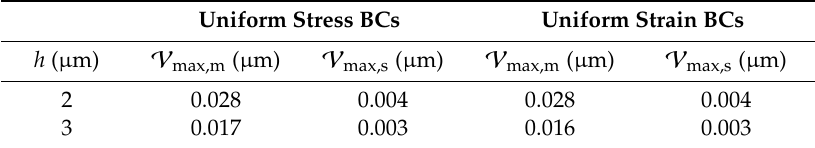
Table 3. Monte Carlo simulation: e ff ect of the target in-plane film width h and of the type of BCs on the values of mean V max,m and standard deviation V max,s of the scattered amplitude of oscillations.